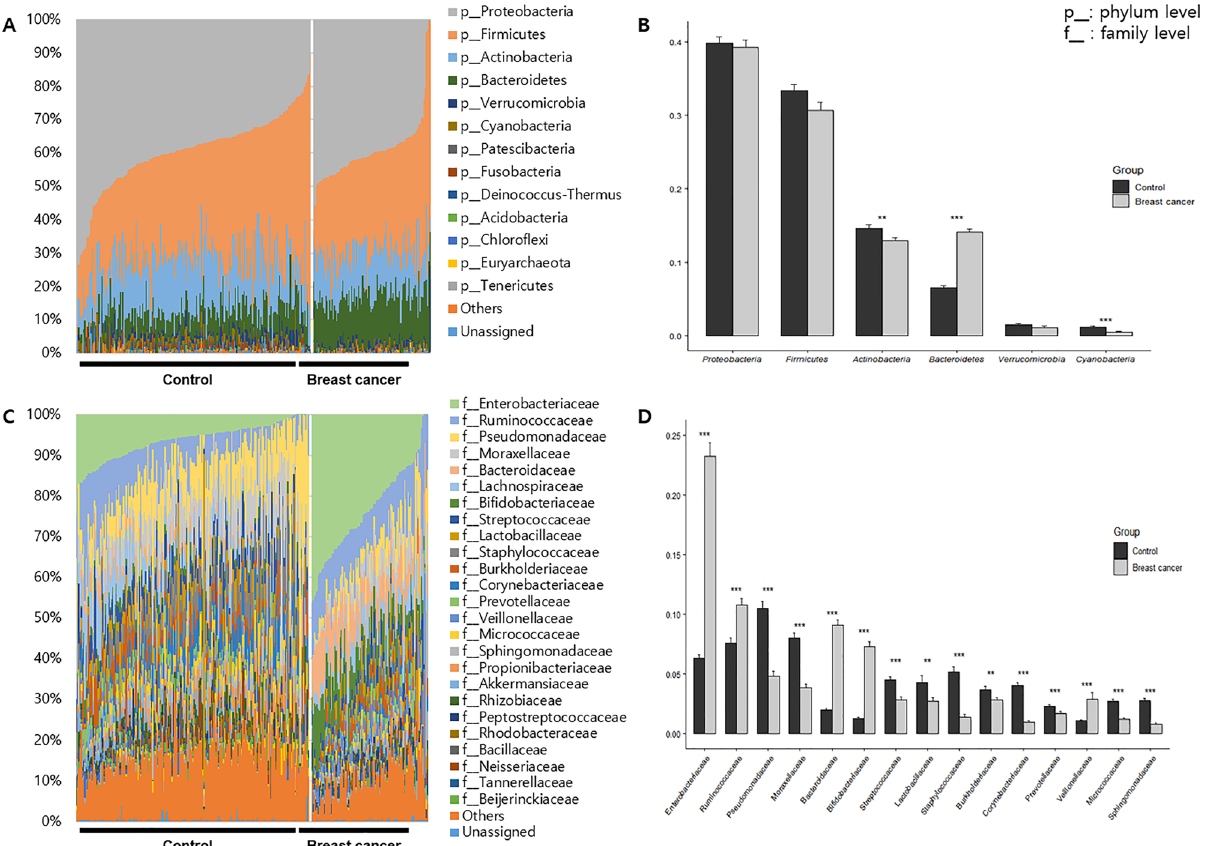
Figure 2. Metagenome profiles in serum of patients with breast cancer and healthy controls. ( A ) The composition of microbiome at the phylum level, ( B ) the difference of main phyla, ( C ) the composition of microbiome at the family level, and ( D ) significantly different taxa at the family